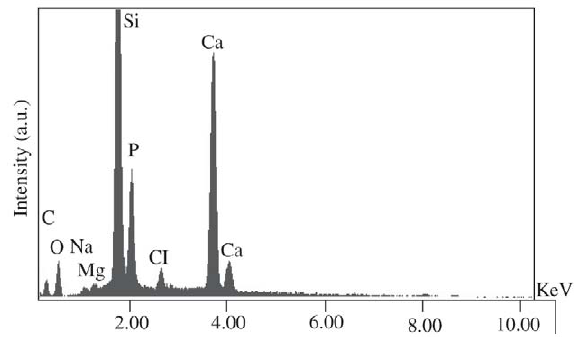
Figure 3. EDS for sample chemically treated with TEOS for 1h and immersed for 10 days in SBF solution.